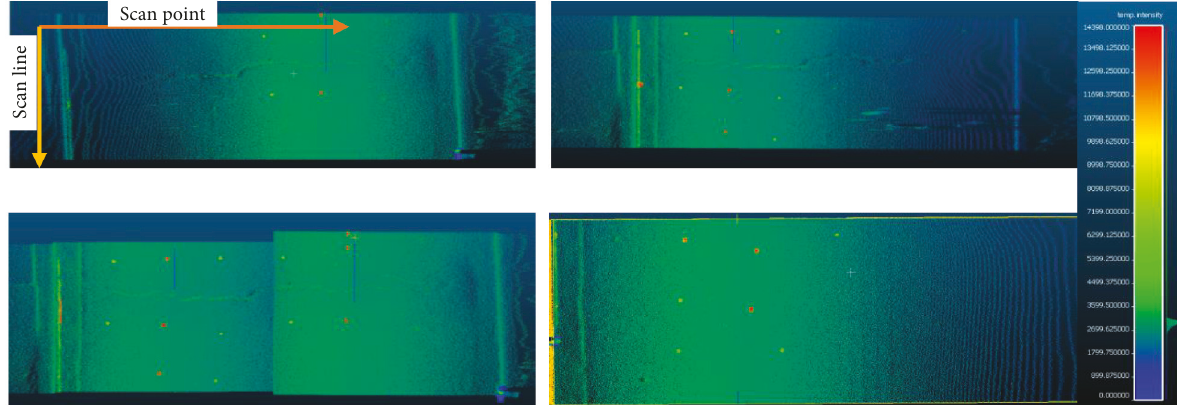
Figure 4: The generated point cloud of the large crack. (a) The visualization of the crack observed from the (a) left and (b) right side of the crack and (c) the combined point cloud. The displayed color shows the intensity